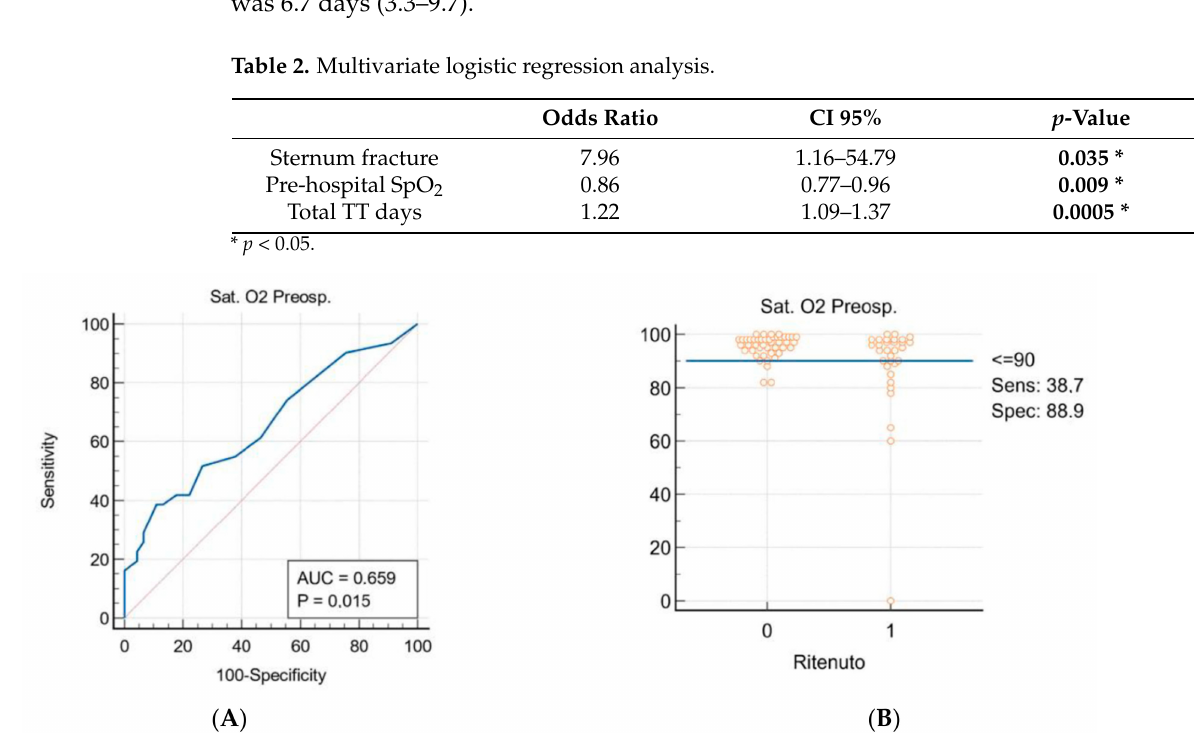
Figure 2. ( A ) SpO 2 ROC Curve; ( B ) patients’ distribution based on pre-admission SpO 2 .